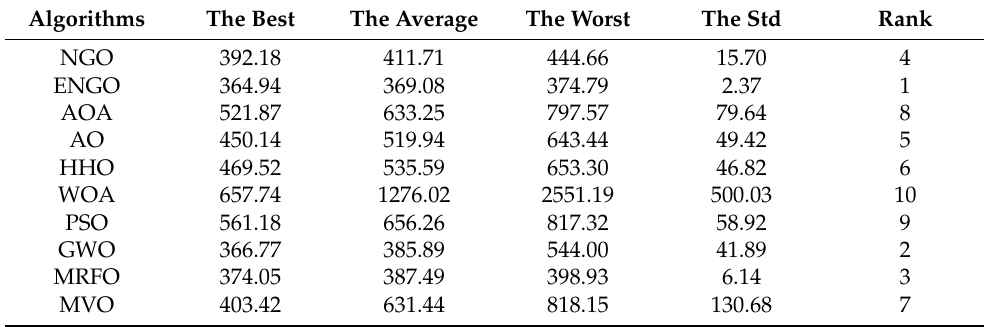
Table 11. Results of the different algorithms in solving the 72-bar truss design problem.